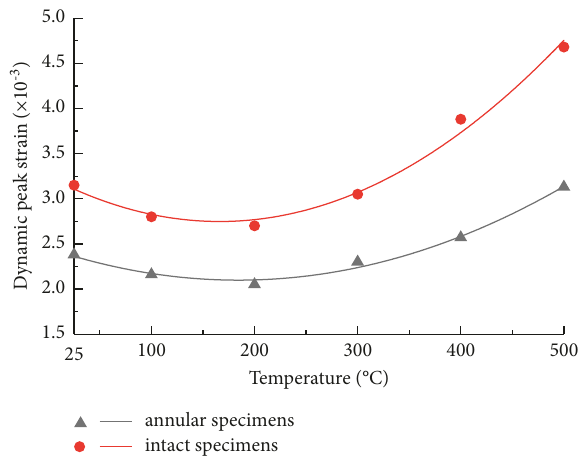
Figure 10: Dynamic tensile strength of samples after different temperatures.